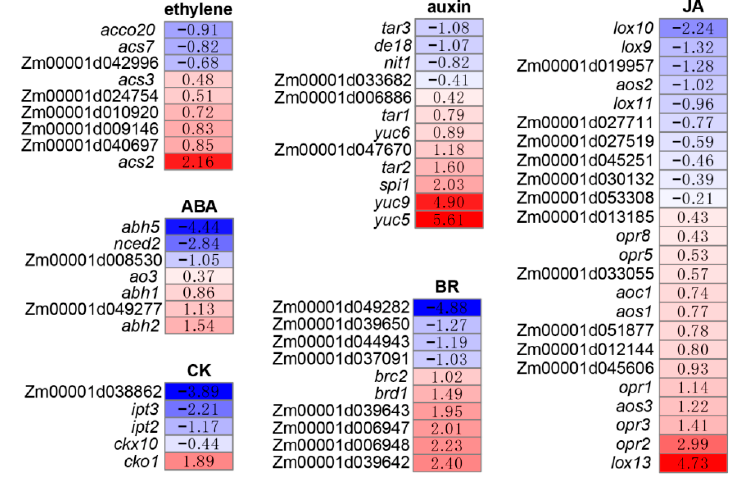
Figure 4. DEGs related to phytohormone-related. Pathways include: ethylene, auxin, Abscisic Acid (ABA), cytokinin (CK), Brassinosteroids (BR) and the Jasmonic Acid (JA). The data and the colors of the rectangles indicate mean log 2 (fold change) of the DEGs; plant metabolic pathway databases were used for pathway analysis [40].